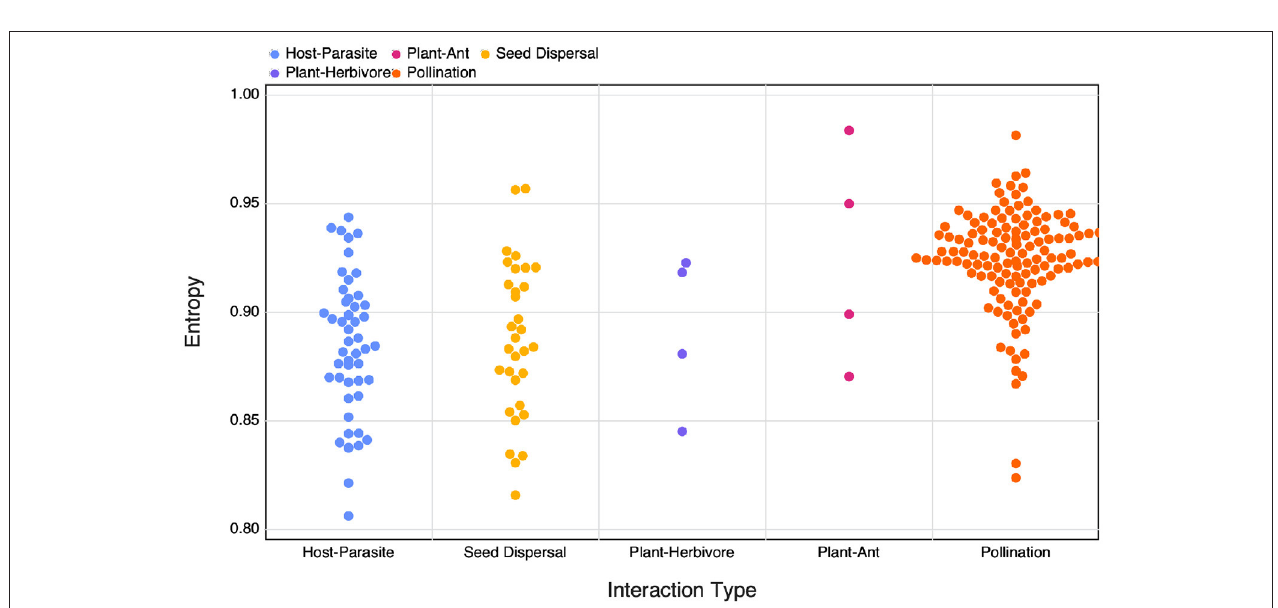
FIGURE 3 | The relationship between SVD entropy and the nestedness (left) , spectral radius (central) and connectance (right) of ecological networks. Colours indicate the different interaction types of the networks.